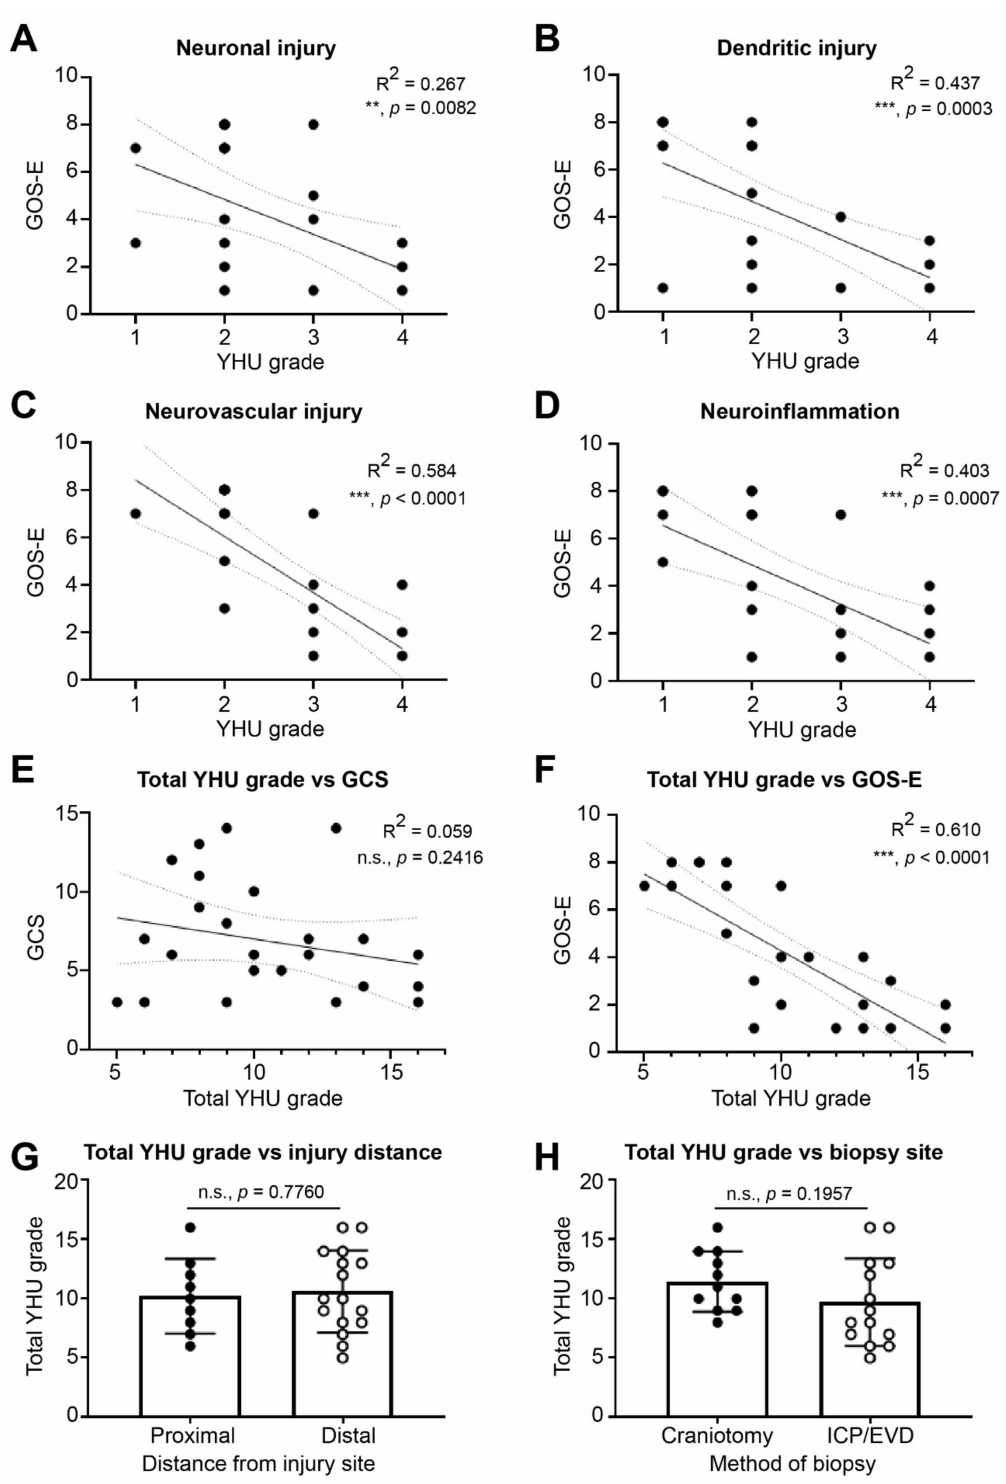
Figure 6. Linear regression analysis between the YHU grade and GOS-E. The GOS-E was compared with the YHU grade for ( A ) neuronal injury, ( B ) dendritic injury, ( C ) neurovascular injury, and ( D ) neu- roinflammation. Combination of all YHU grades for neuronal injury, dendritic injury, neurovascular injury, and neuroinflammation of each patient compared with ( E ) GCS, ( F ) GOS-E, ( G ) distance from injury site, and ( H ) method of biopsy. n.s. = non-significant, ** = p < 0.01, *** = p <